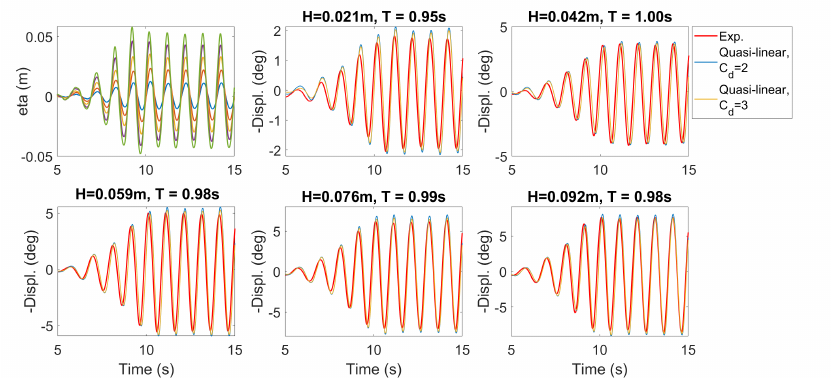
Figure 24. Wave elevation ( eta ) and free motion ( Displ .) of WEC+BB for different wave amplitudes. “Experimental” data is compared to results from the quasi-linear model with C d = 2 and C d = 3, both with K fb = 0.4 Nm.